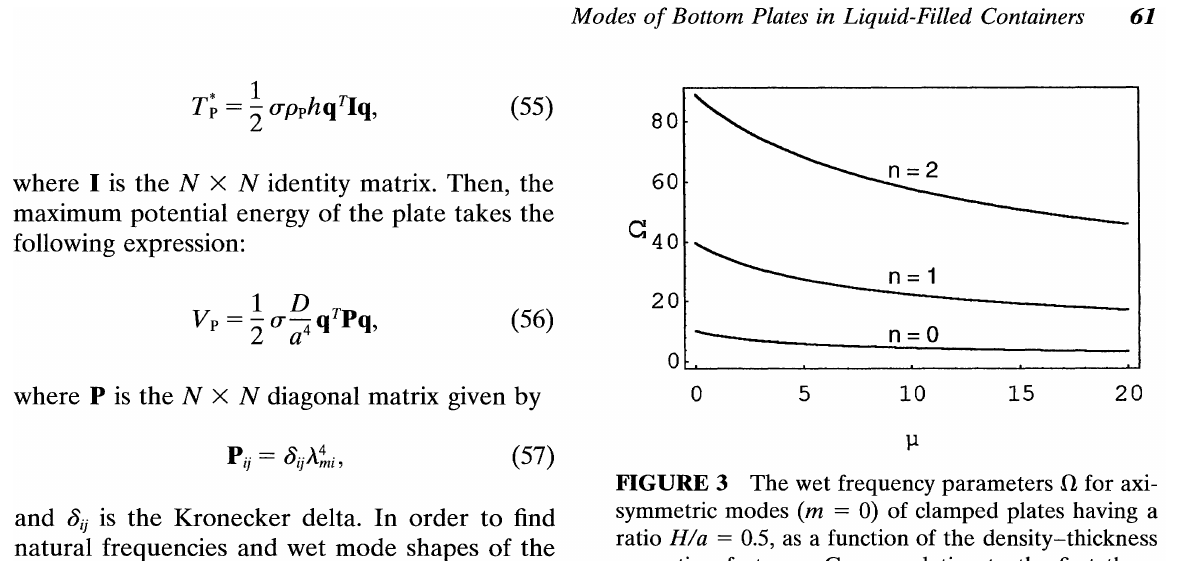
FIGURE 3 The wet frequency parameters n for axi symmetric modes (m = 0) of clamped plates having a ratio H/a = 0.5, as a function of the density-thickness correction factor JL. Curves relative to the first three axisymmetric modes.